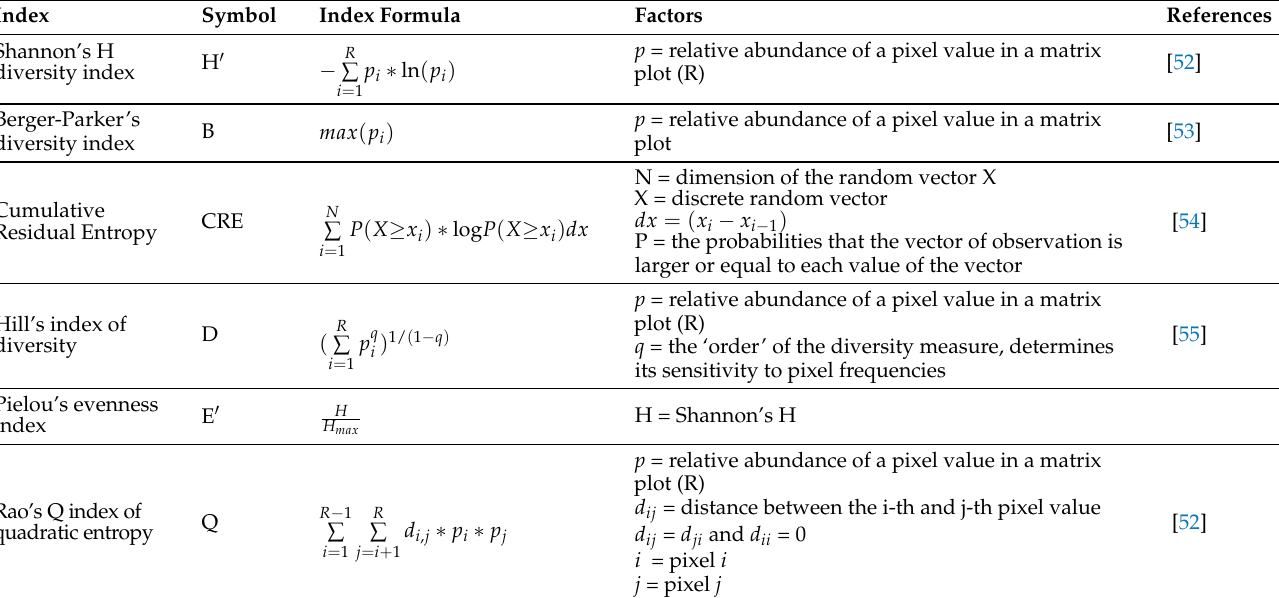
Table 2. List of the used R rasterdiv heterogeneity